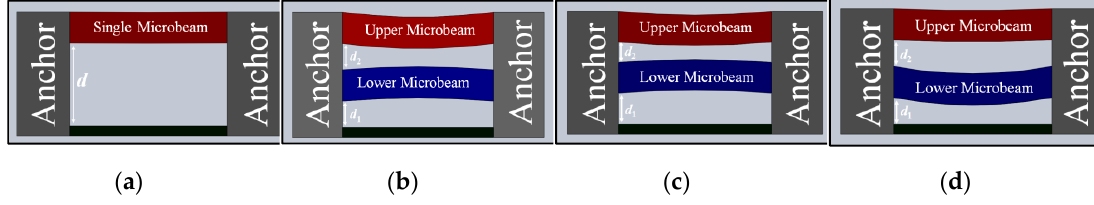
Figure 6 . Comparison between the variations of the upper microbeam maximum static deflections with the DC voltage for all three cases with the single-microbeam case.